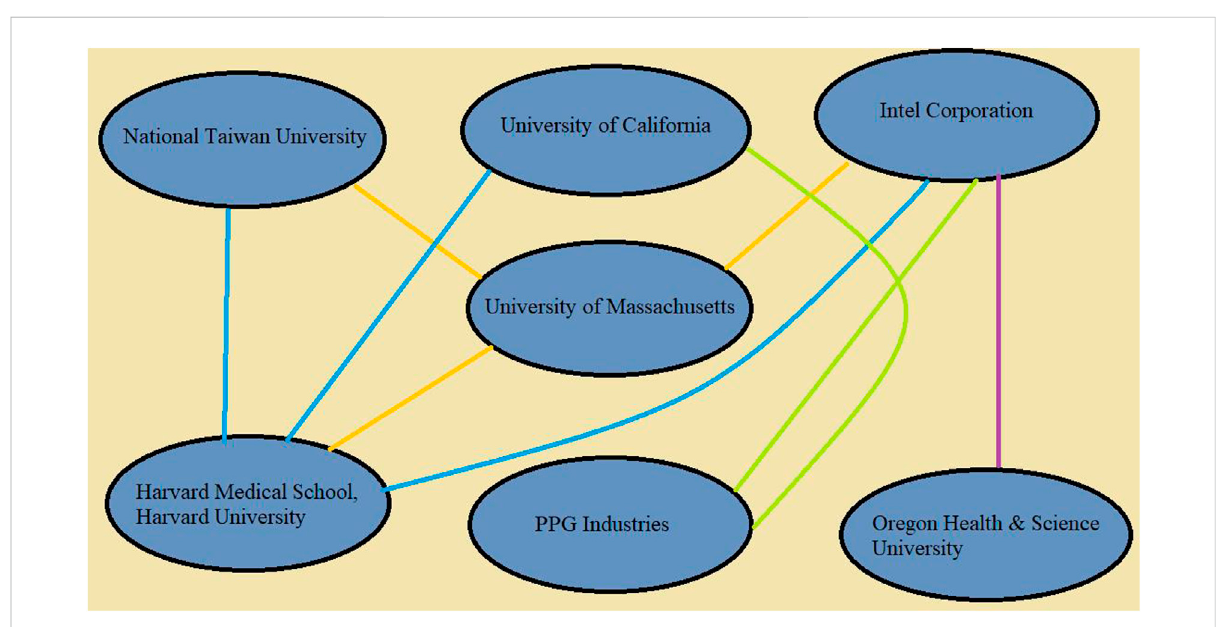
FIGURE 4 Interconnection between organizations for cancer therapy through use of